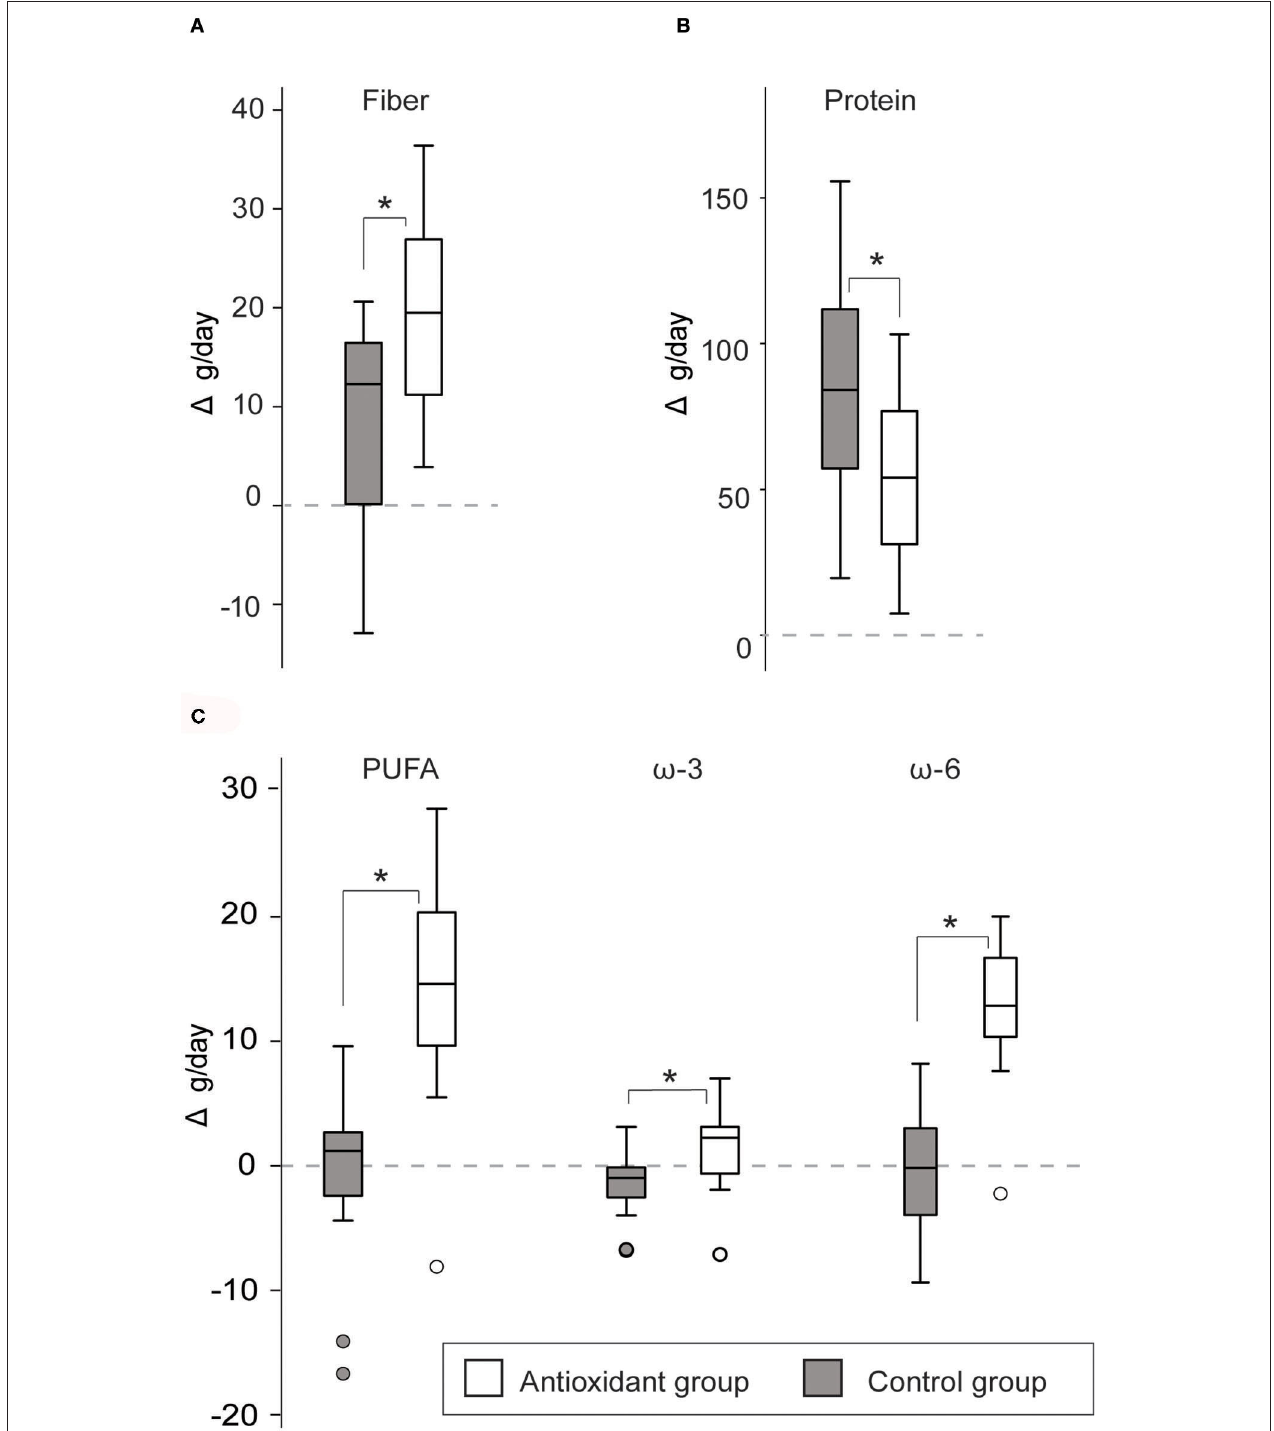
FIGURE 4 | Change in the mean daily intake of macronutrients [fiber (A) , protein (B) , polyunsaturated fatty acids (PUFA), ω 3 PUFA, and ω 6 PUFA (C) ] from Sea level to Altitude in the antioxidant and control group. Presented as mean Sea level—Altitude intra-individual change (%) and standard deviation. *indicates significant difference, p < 0.05. The p -value is obtained from comparing the change from Sea level to Altitude between the groups using t -test or MW tests depending on the normality of the data.